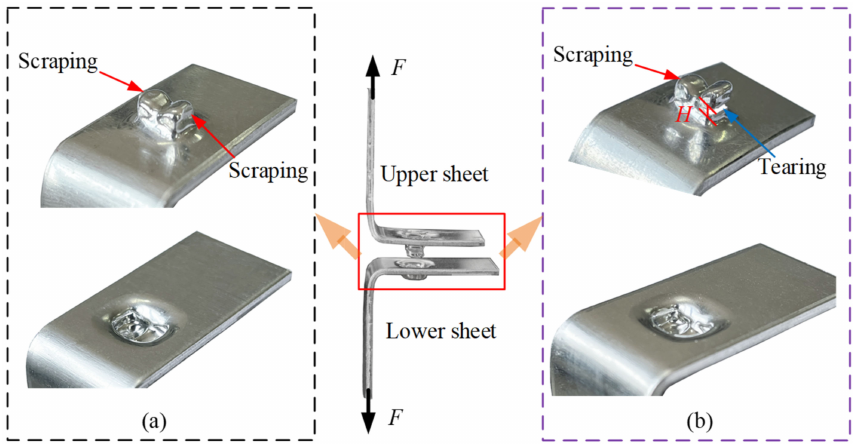
Figure 14. Failure modes of the joint in the peel tests. ( a ) Unbuttoning and ( b ) Single-punch tearing. The failure modes are affected by the shear and peel loads of the joints, as shown in Table 3. The failure rates due to unbuttoning and tearing caused by single-punch tearing of the joints are 85.2% and 14.8%, respectively, in the peel test, and the unbuttoning,